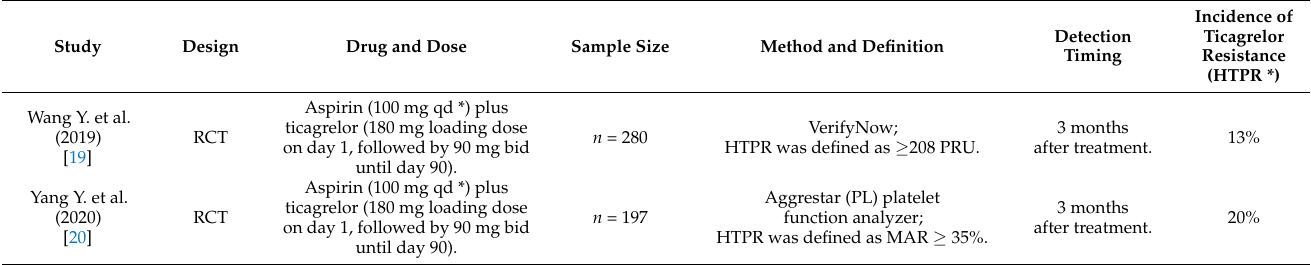
Table 3. Incidence of ticagrelor resistance in clinical